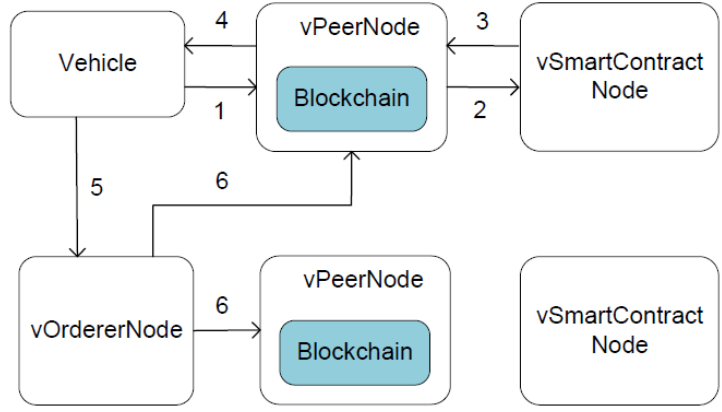
Figure 7. How to disseminate a report via blockchain.